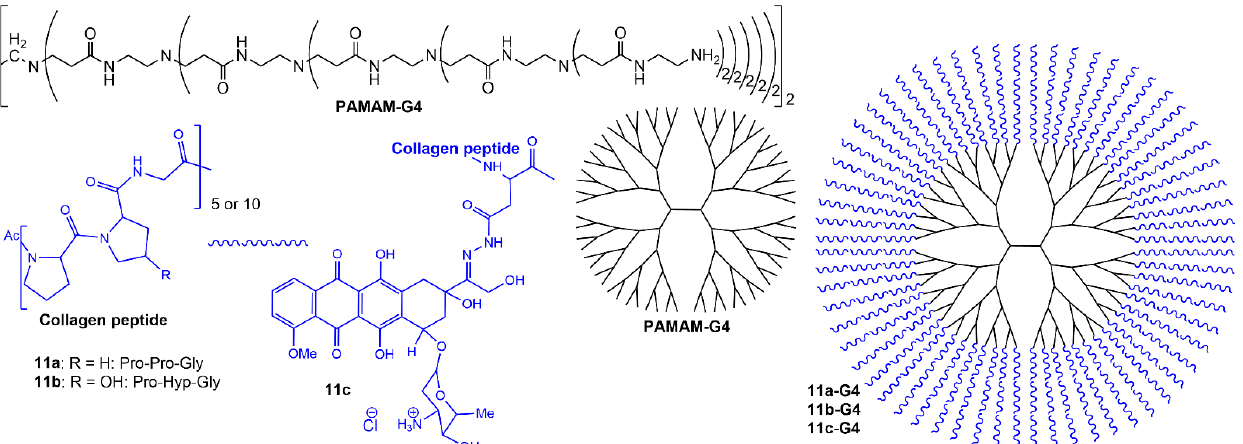
Figure 10. Structure of small amphiphilic Janus dendrimers suitable for affording hydrogels.